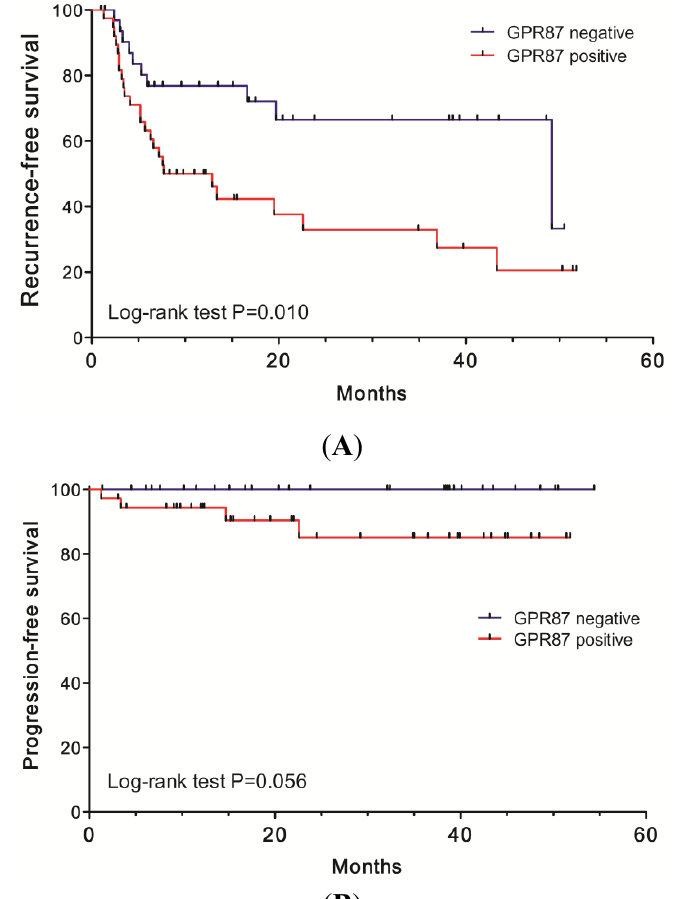
Figure 5. Intravesical recurrence-free survival curves ( A ) and progression-free survival curves ( B ) Blue line: patients with GPR87-negative bladder cancers, Red line: patients with GPR87-positive bladder